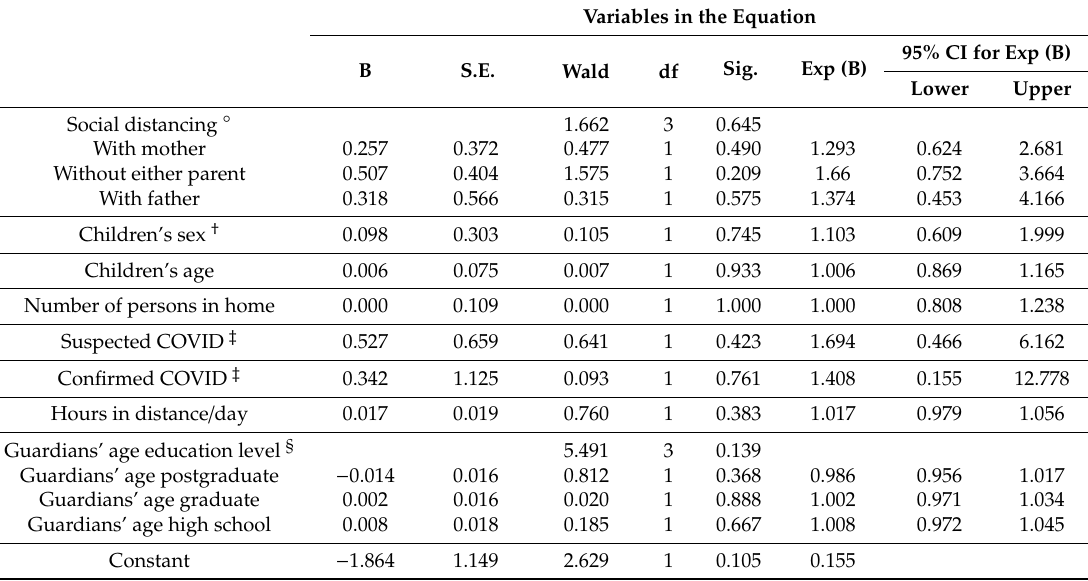
Table 5. The presence of anxiety via NRS